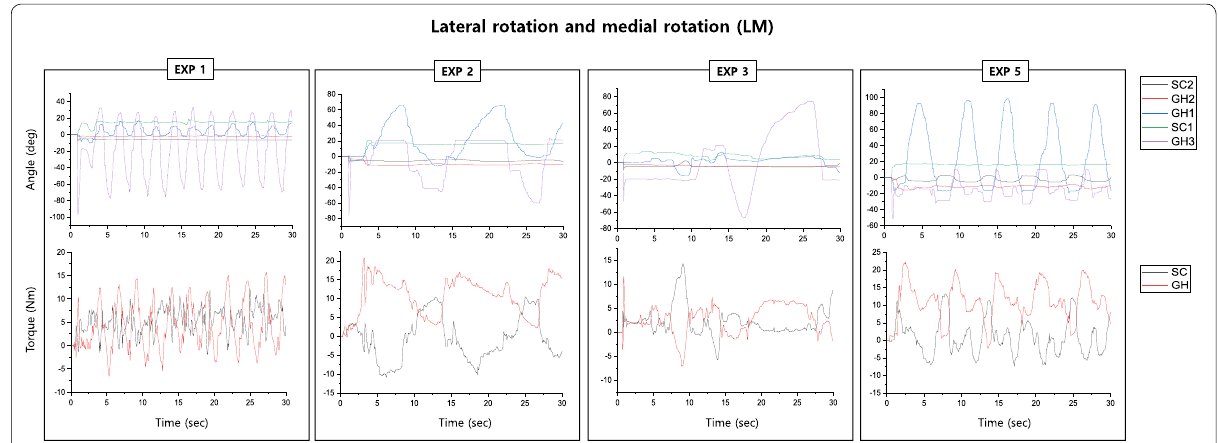
Fig. 7 Experiment values of the raw data of angle and torque in lateral and medial rotation (LM) exercise from the experts ( EXP expert, SC sterno‑clavicular joint, GH glenohumeral joint). The x‑axis indicates the time (unit: second). The top and bottom y‑axes represent the angle (unit: degree) and torque (unit: Nm), respectively